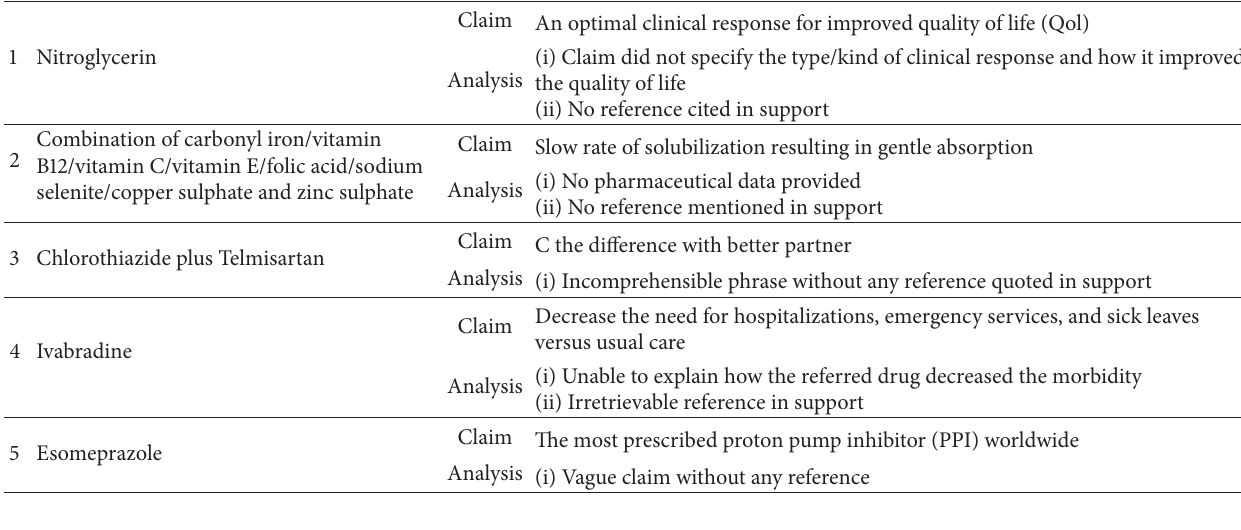
Table 2: Examples of ambiguous claims in drug advertisements.